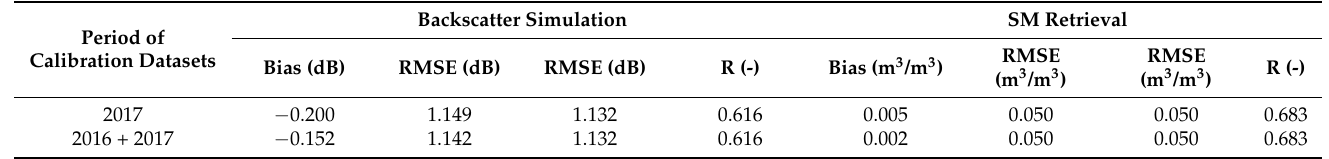
Table 6. Statistical metric between Sentinel-1A observation (in situ SM) and AIEM simulation (retrieved SM) with the best optimization parameters.